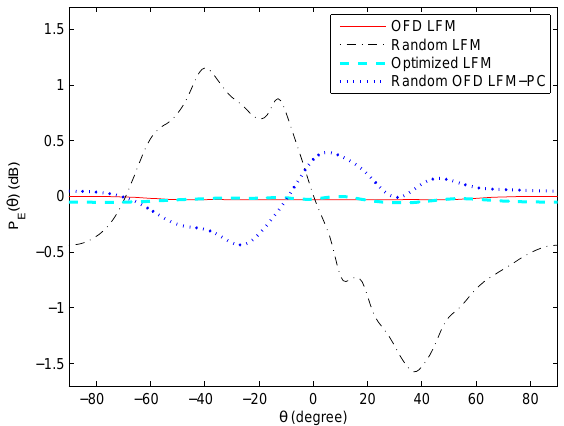
Figure 8. The beampatterns of different angular